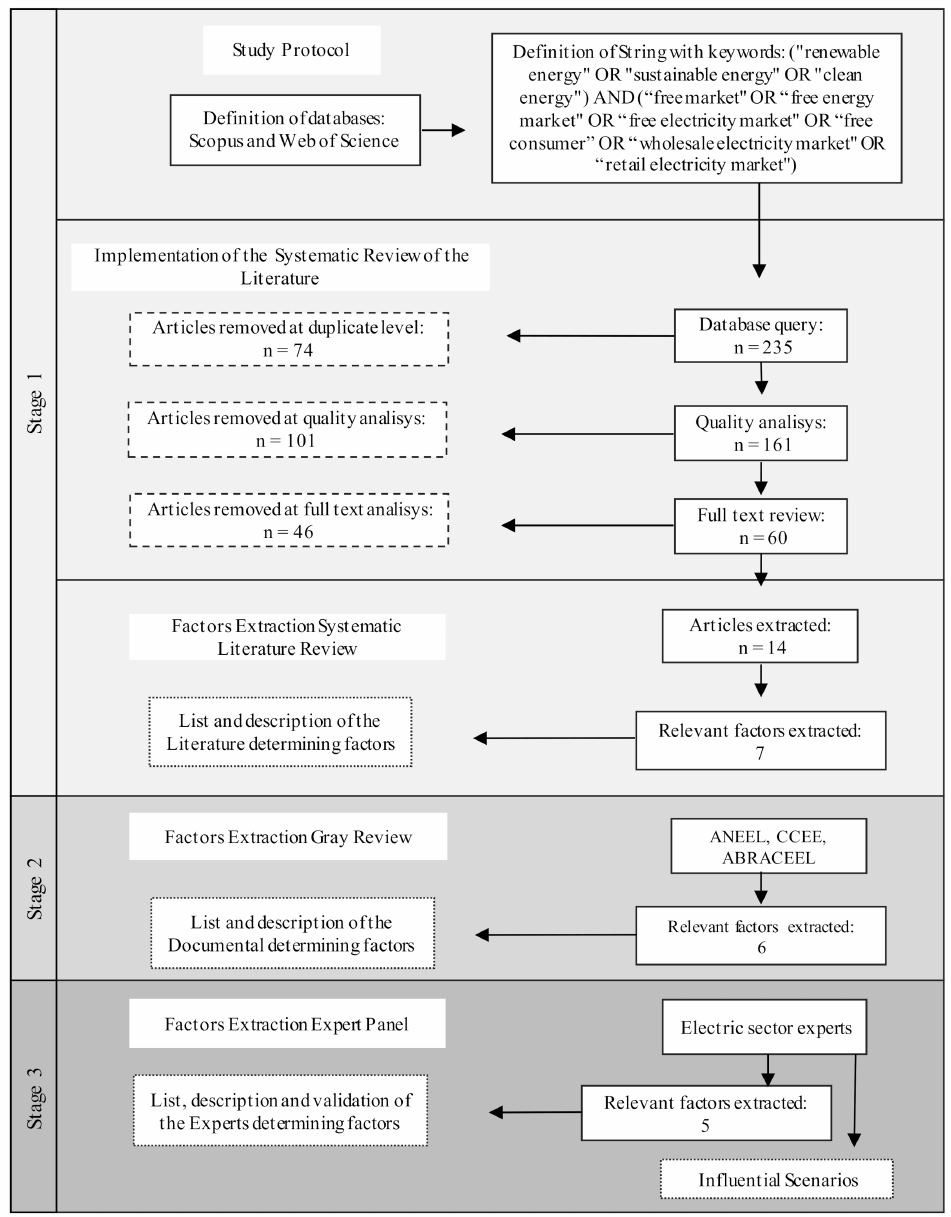
Figure 1. Research